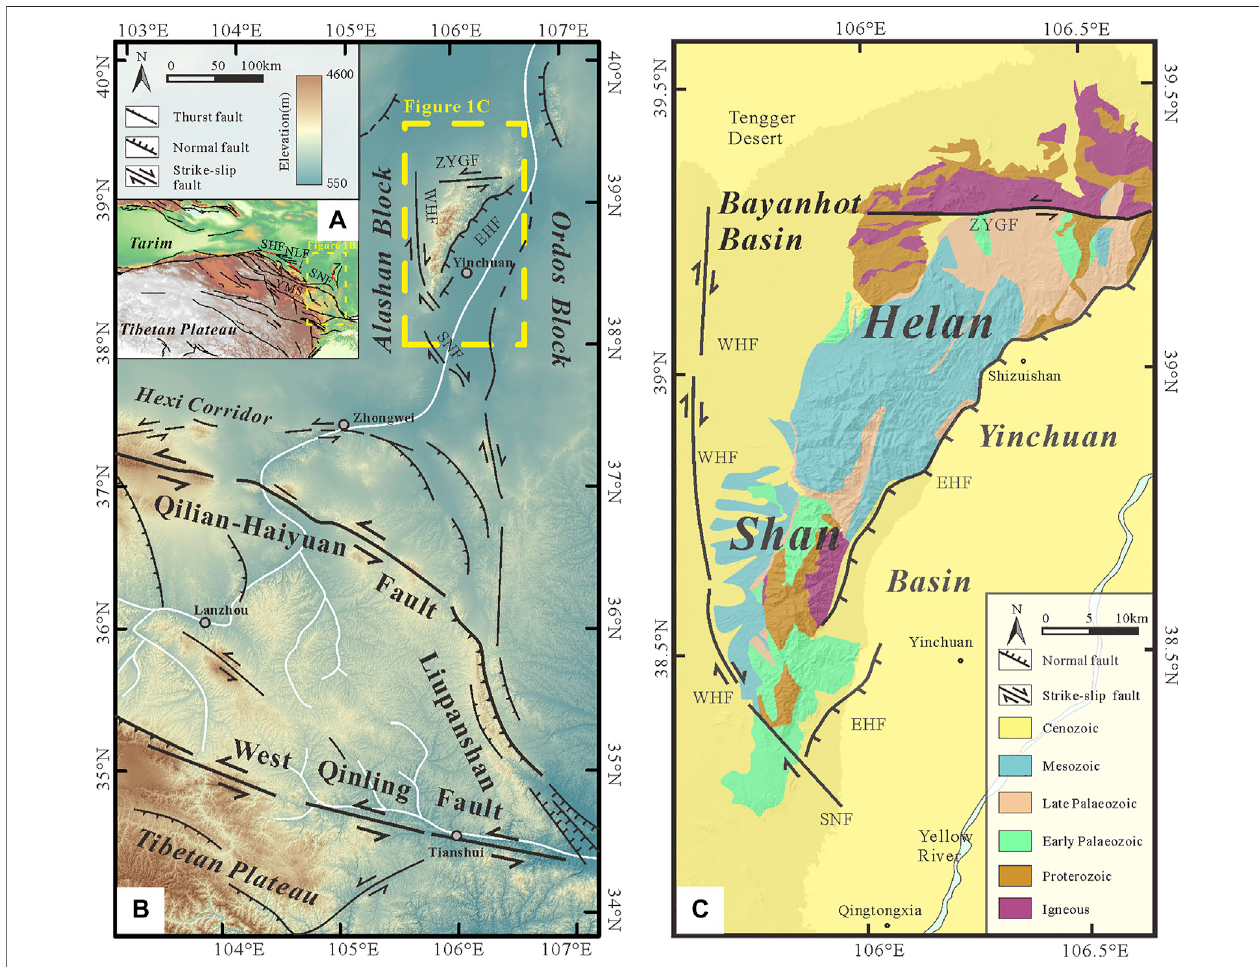
FIGURE1|(A) Tectonic locationofthestudyarea. (B) Active tectonicfeaturesofthenortheastern marginoftheTibetanPlateau,modi fi edfromZhengetal.(2016) and Yu et al. (2016). (C) Geological map of the Helan Shan area, modi fi ed from Geological Map of Ningxia Hui Autonomous Region, the People ’ s Republic of China (2014). Fault names: SHP, South Heli Shan Fault; NLP, North Longshou Shan Fault; WHF, West Helan Shan Fault; EHF, East Helan Shan Fault; SNF, Sanguankou- Niushoushan Fault; ZYGF, Zhengyiguan Fault.